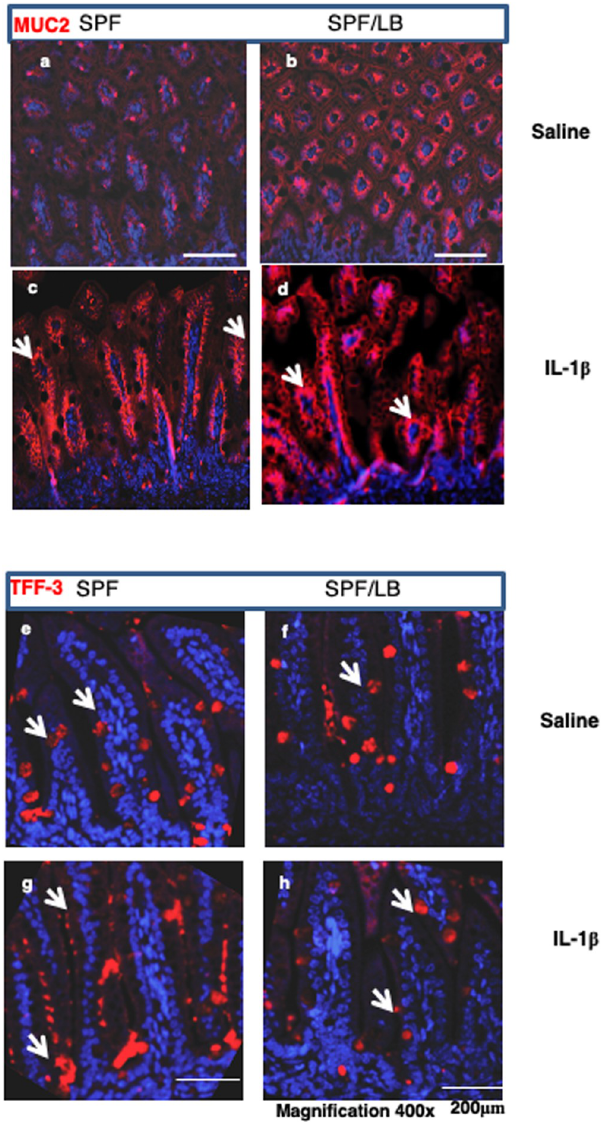
Fig 4. Maternal LB modulates IL-1 β -induced goblet cell Tff3 and MUC2 response to inflammatory stress in pre- weaned mice. a,b) Immunofluorescence detection of MUC2 molecules (red) in the mouse goblet cells in SPF (a) vs SPF/LB pups (b). Representative areas (n = 3 per group) are shown Bar 100 μ M, magnification 400x. c,d) Representative areas of MUC2 exclusion from goblet cells in response to IL-1 β stimulation in SPF (c) or SPF/LB (d) pups are shown; magnification 400x. e,f) Representative area of immunofluorescence staining of TFF3 molecules (red) in the goblet cells. Left: SPF (e), and Right: SPF/LB (f) n = 3/per group) group, g,h) . IL-1 β induced TFF3 (red) secretion from goblet cells was detected by immunofluorescence staining. Representative areas were shown: Left: SPF ( g ), and Right: SPF/LB ( h ) (n = 3/per group) (magnification 400x).